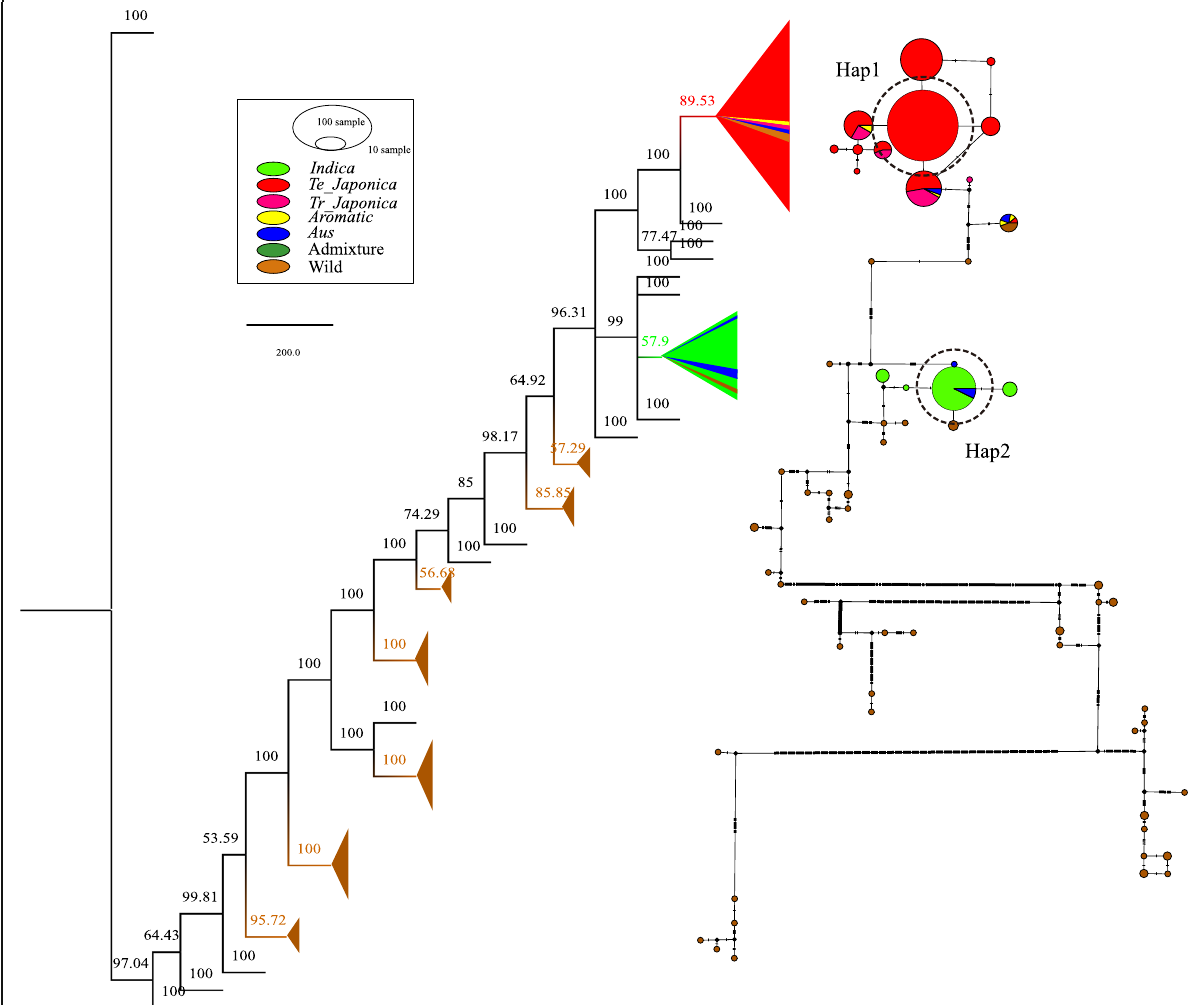
Fig. 4 The haplotype tree and TCS network. The haplotype tree and TCS network structure map obtained from 412 samples. The numbers on the tree branches represent confidence values. Different colors represent different populations, and circle size represents the number of samples. Here, haplotypes are mainly dominated by two major haplotypes (dashed circles). Hap1 and Hap2 represent japonica type and indica type,